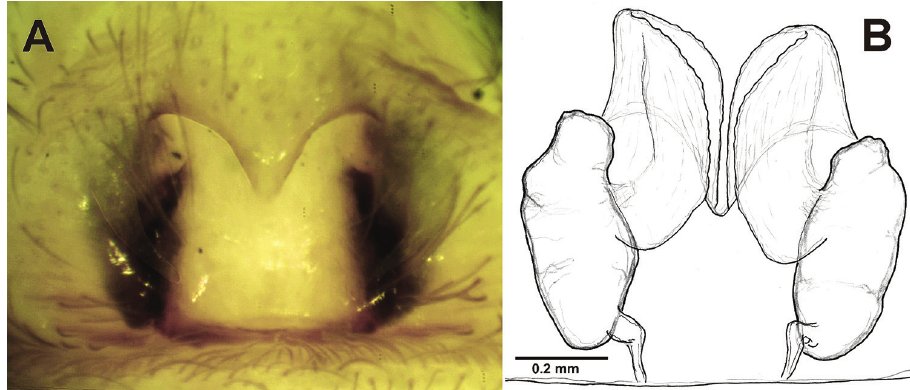
Figure 7. Epigyne of Pireneitega major , lectotype. A Ventral B Dorsal.